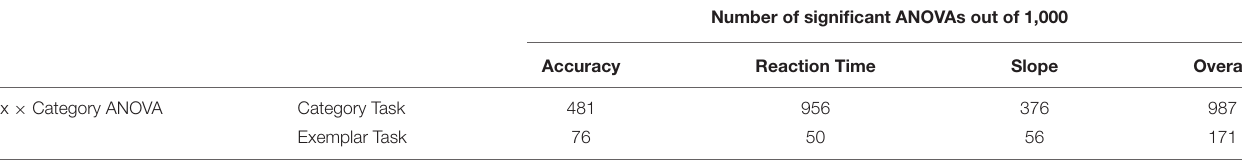
FIGURE 3 | Accuracies, Reaction Times (RTs) and slopes for the exemplar task, for children (top panels) and adults (bottom panels). Slopes are determined from a least-squares regression of RT vs. array size. Error bars indicate 1 Standard Error of the Mean. TABLE 4A | Power Analysis, scenario (i): no difference between faces and interests in ASD subjects. Number of significant ANOVAs out of 1,000